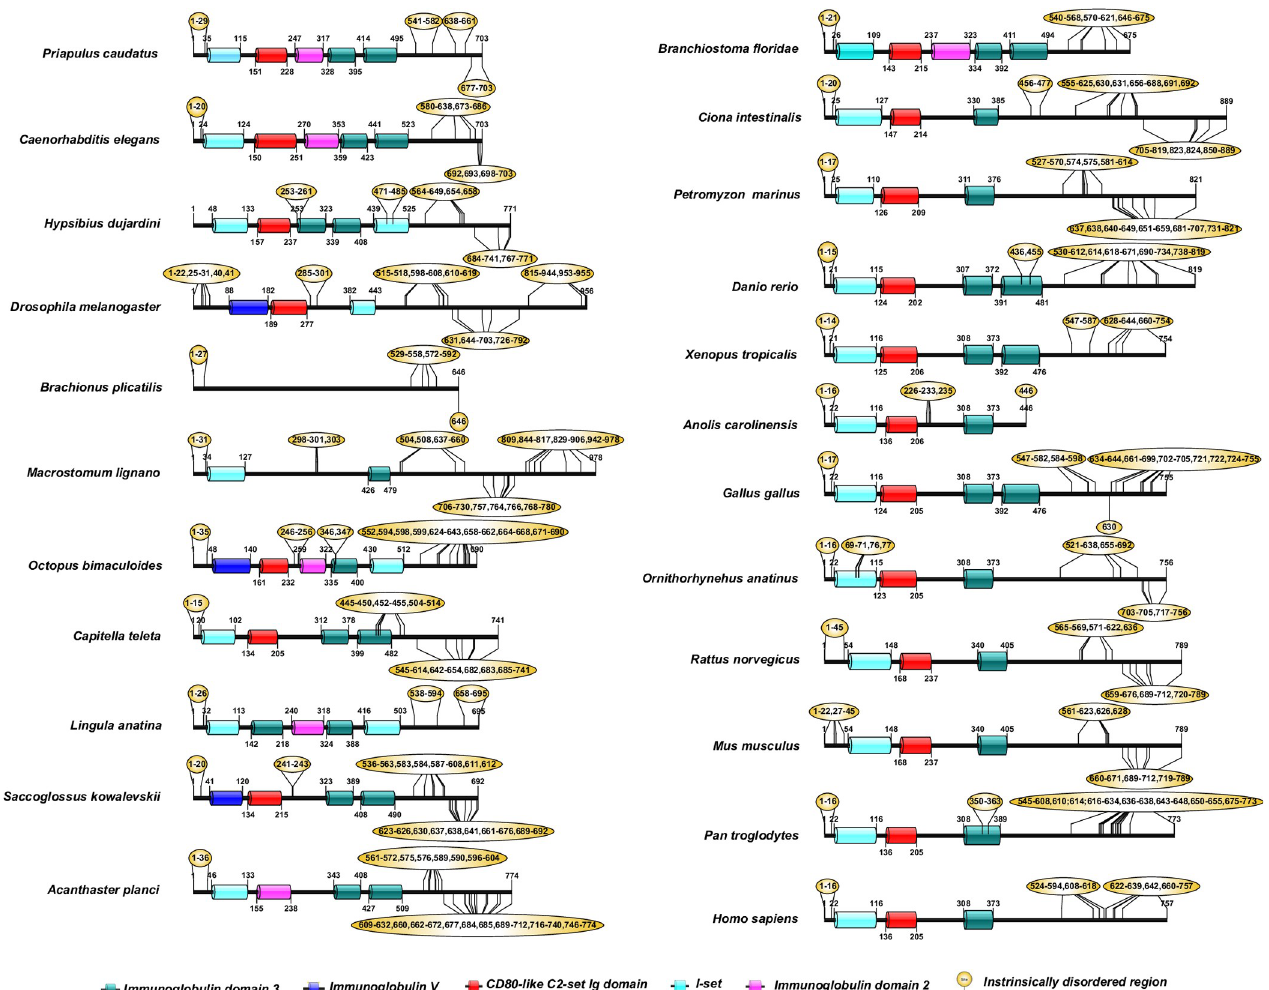
Fig 3. Domain organization in KIRREL1 and its orthologs. Different colors represent the Ig domain subsets: Ig2 as pink, Ig3 as green, I-set as light blue, CD80-like C2-set as red, Ig V-set as dark blue, and intrinsically disordered regions as yellow bubbles.